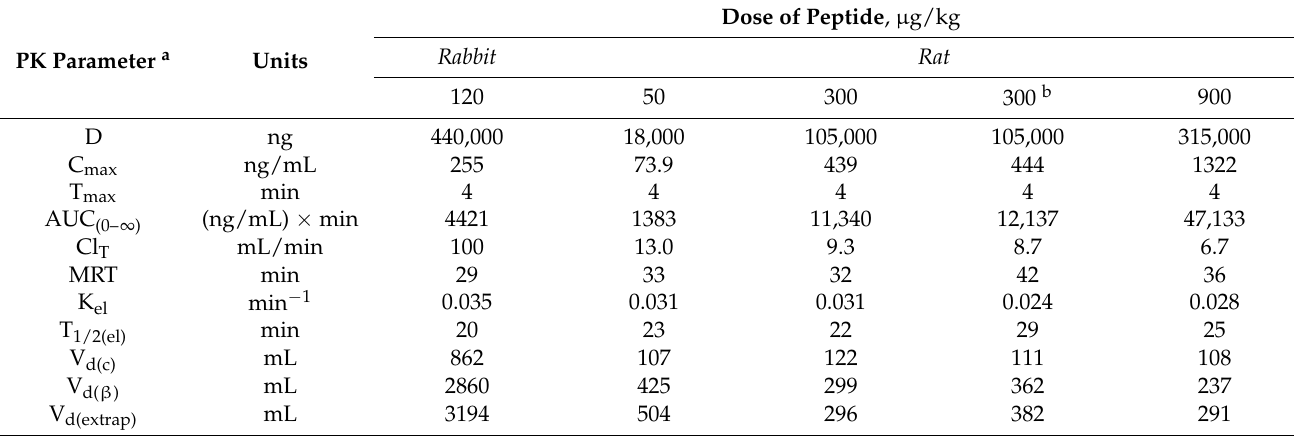
Table 2. Calculated values of the main pharmacokinetic (PK) parameters of HAEE in the blood of test animals after a single intravenous bolus injection of the